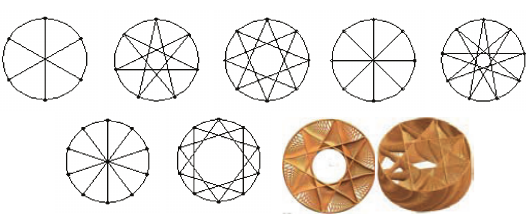
Fig.3. Different patterns of wound impellers Figure 3. Different patterns of wound impellers.